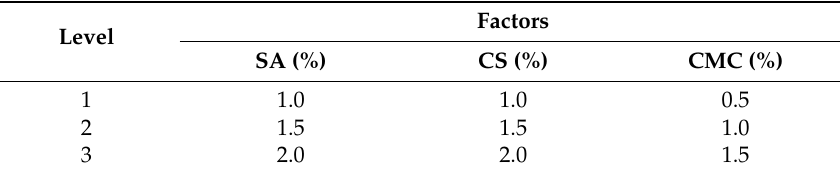
Table 2. The factors and levels of orthogonal experimental design.